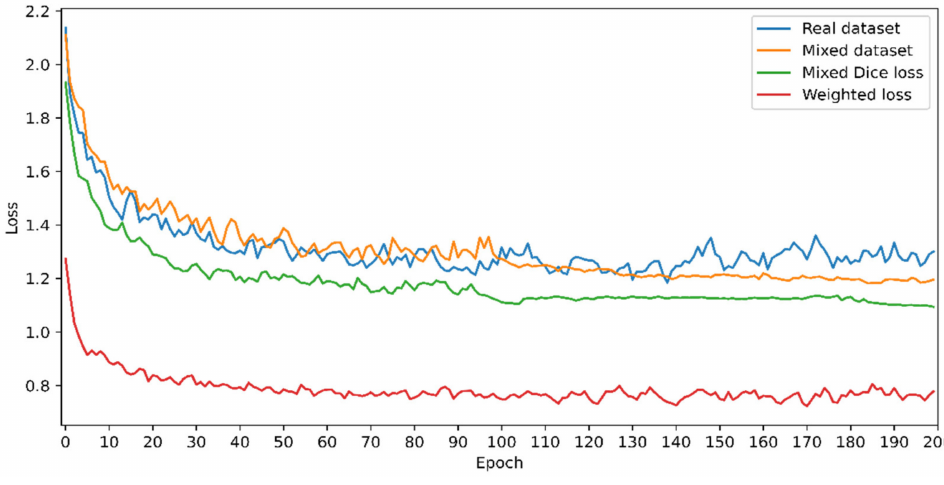
Figure 11. Total validation losses.